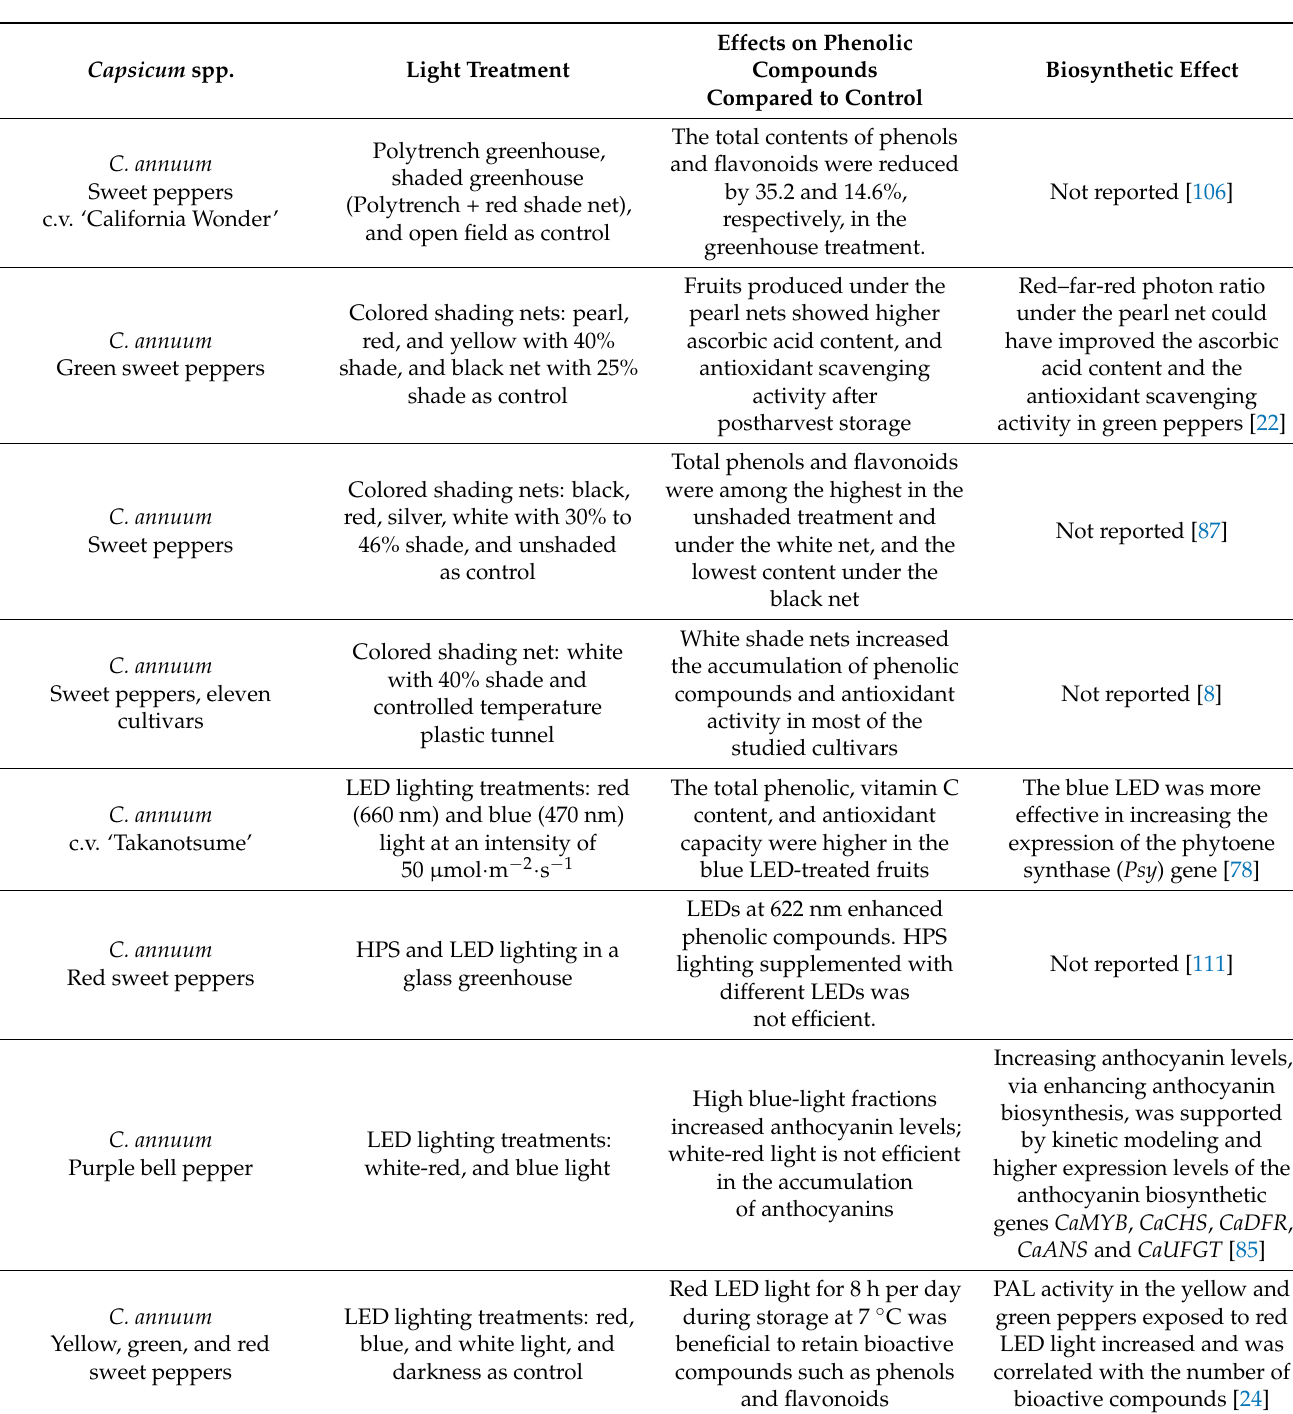
Table 3. Effect of light-condition treatments on the phenolic compounds content in Capsicum species.